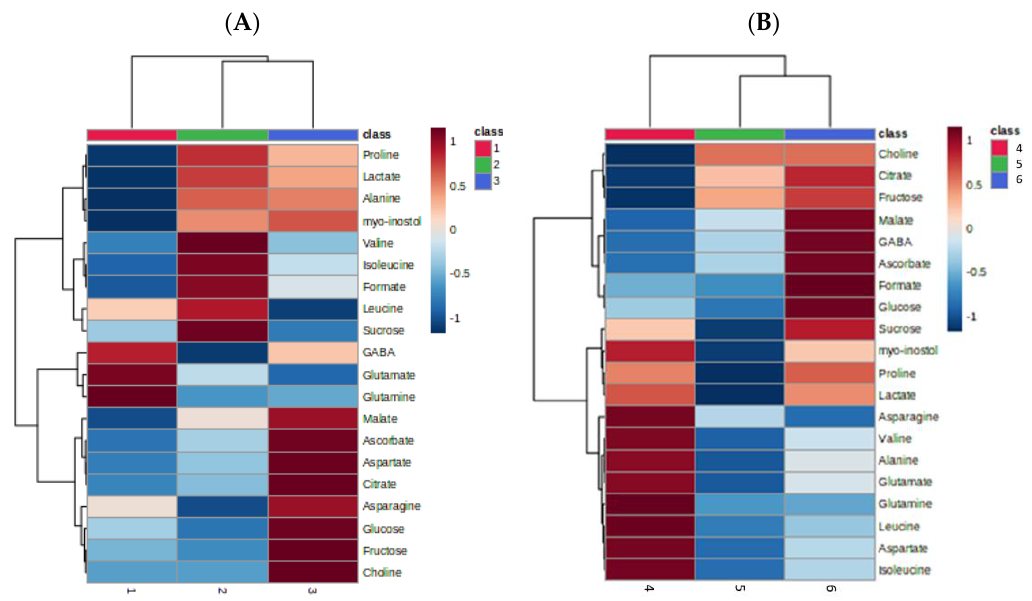
Figure 3. VIP scores (variable importance in projection) plot, derived from the partial least squares discriminant analysis (PLS-DA), is shown along with the corresponding heat map in which red and blue colors indicate the level of metabolites. The analysis is performed for ( A ) the rootstock used ( n = 3) and ( B ) the substrate used ( n = 3), where 1 to 3 corresponds to the rootstock type as (1) Citrus macrophylla ; (2) Citrus aurantium ; and (3) Citrus aurantium/Citrus sinensis ; and 4 to 6 is related to the culture (4) 75% peat + 25% port sediment; (5) 50% peat + 50% port sediment; and (6) 25% peat + 75% port sediment.